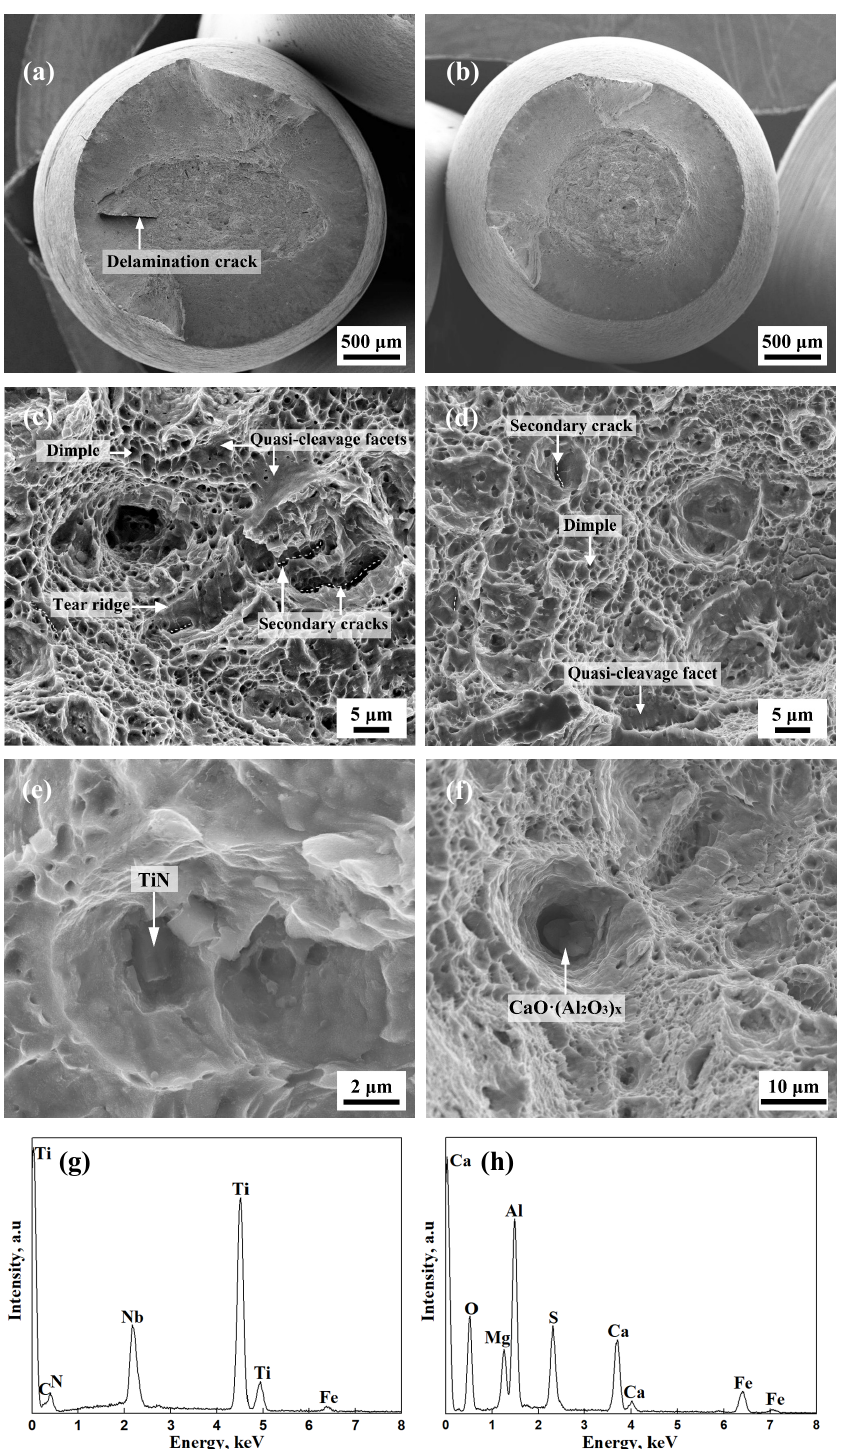
Figure 4. Fracture surfaces of the specimens after tensile testing. ( a ) Tensile fracture of a segregation zone (SZ), ( b ) tensile fracture of a non-segregation zone (NSZ), ( c ) fiber zone of the SZ, ( d ) fiber zone of the NSZ, ( e ) TiN inclusion on a fracture surface, ( f ) CaO·(Al 2 O 3 ) x inclusion on a fracture surface and ( g , h ) the energy-dispersive spectrums of the inclusions.